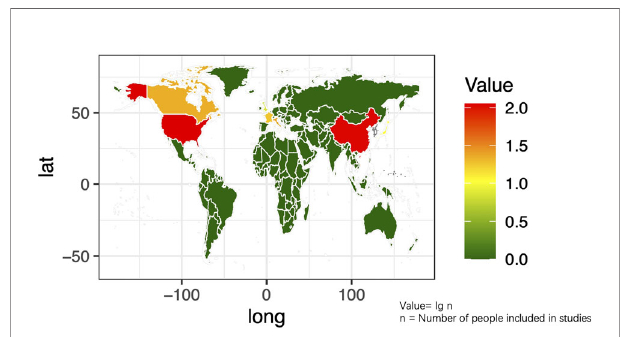
FIGURE 2 | The distribution of the research population in the included studies on the world